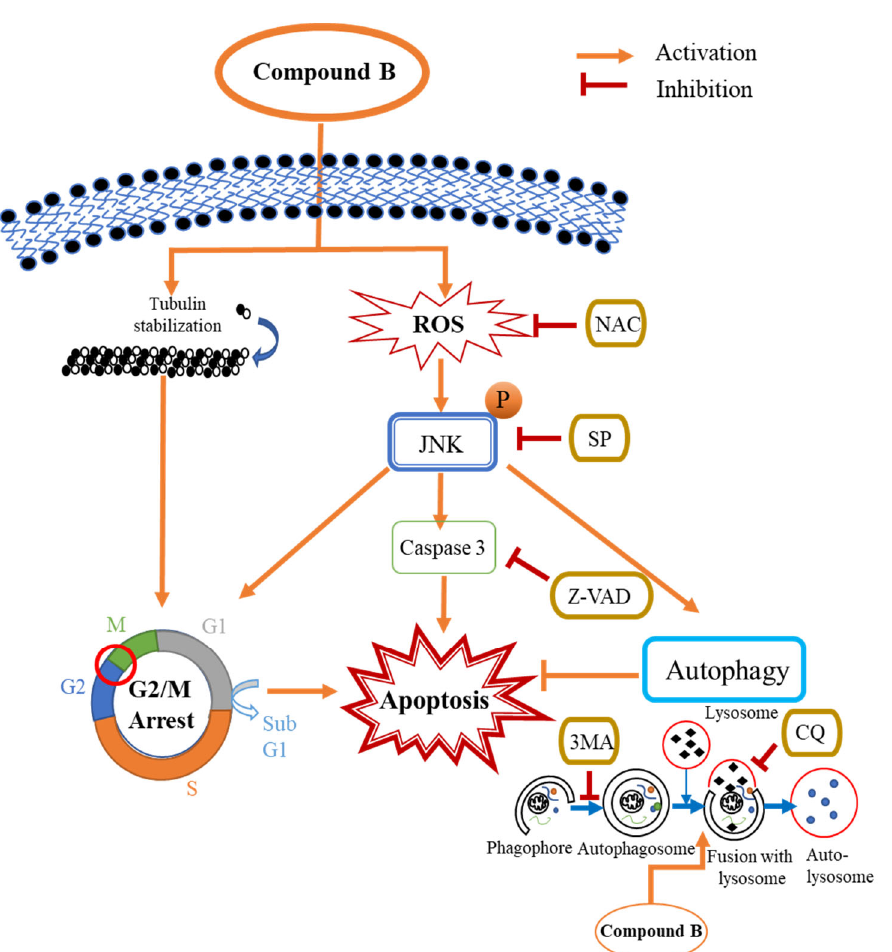
Figure 8. Schematic representation of the proposed mechanism for B ‐ induced apoptosis and autophagy in the Caco2 cells. B induces apoptosis in Caco2 cells through the induction of G2/M phase arrest caused by tubulin stabilization. Simultaneously, B induces apoptosis and autophagy in Caco2 cells via the ROS/JNK signaling pathway. Inhibition of ROS, JNK, and caspases by NAC, SP600125, and Z ‐ VAD ‐ FMK, respectively, decreases B induced caspase ‐ dependent apoptosis in Caco2 cells. 3MA and CQ inhibit autophagy in the Caco2 cells. The inhibition of autophagy by preventing the fusion of lysosomes with autophagosomes by CQ significantly increases the induction of caspase ‐ dependent apoptosis by B in the Caco2 cells.